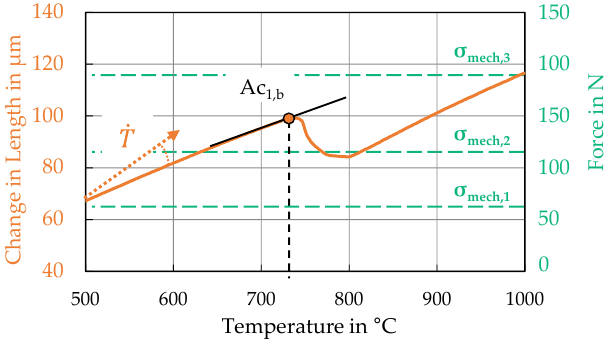
Figure 3. Testing process and evaluation scheme of time-temperature-austenitisation tests.